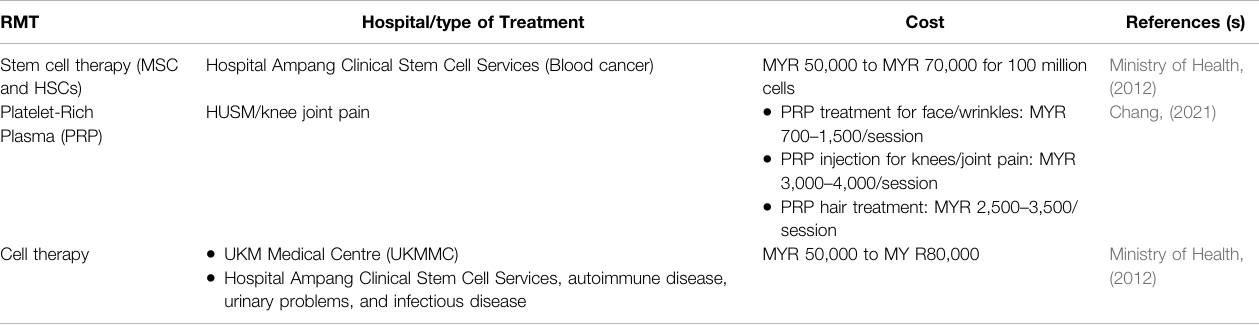
TABLE 4 | Most prominent regenerative medicine therapy in Malaysia.